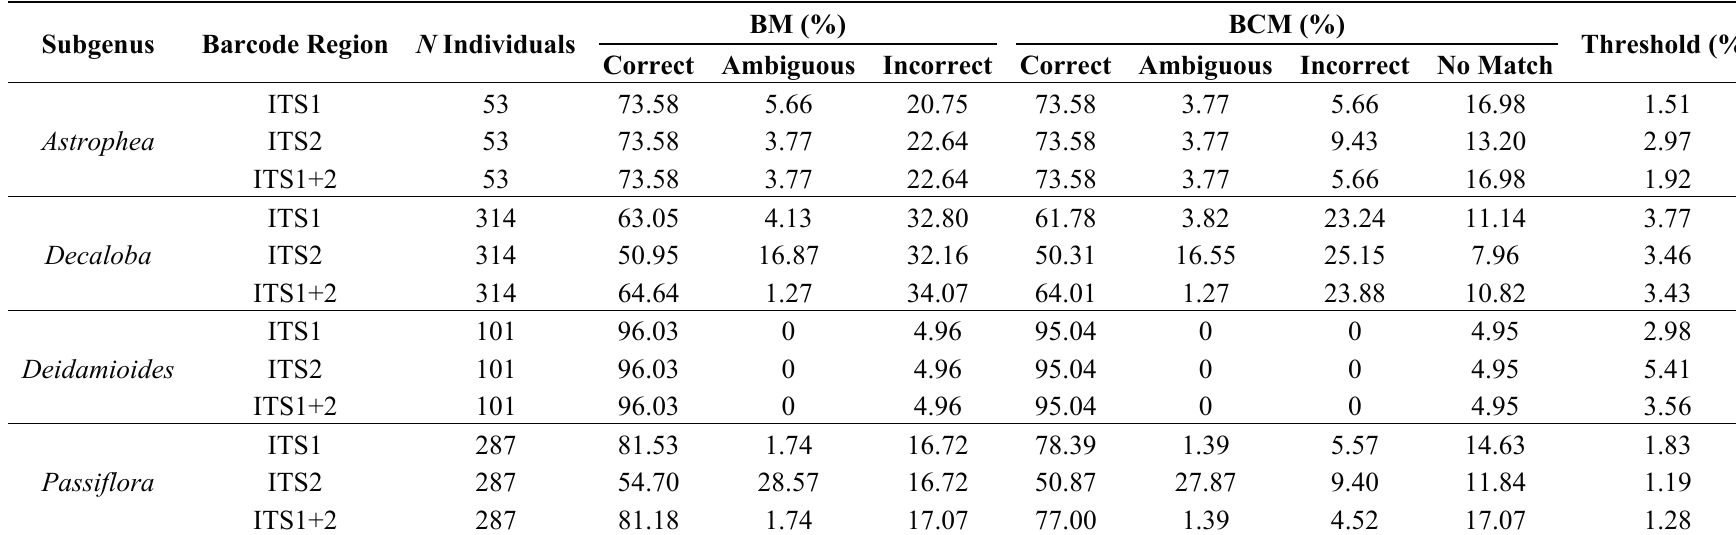
Table 2. DNA barcoding performance evaluated based on similarity methods per ITS dataset per subgenus